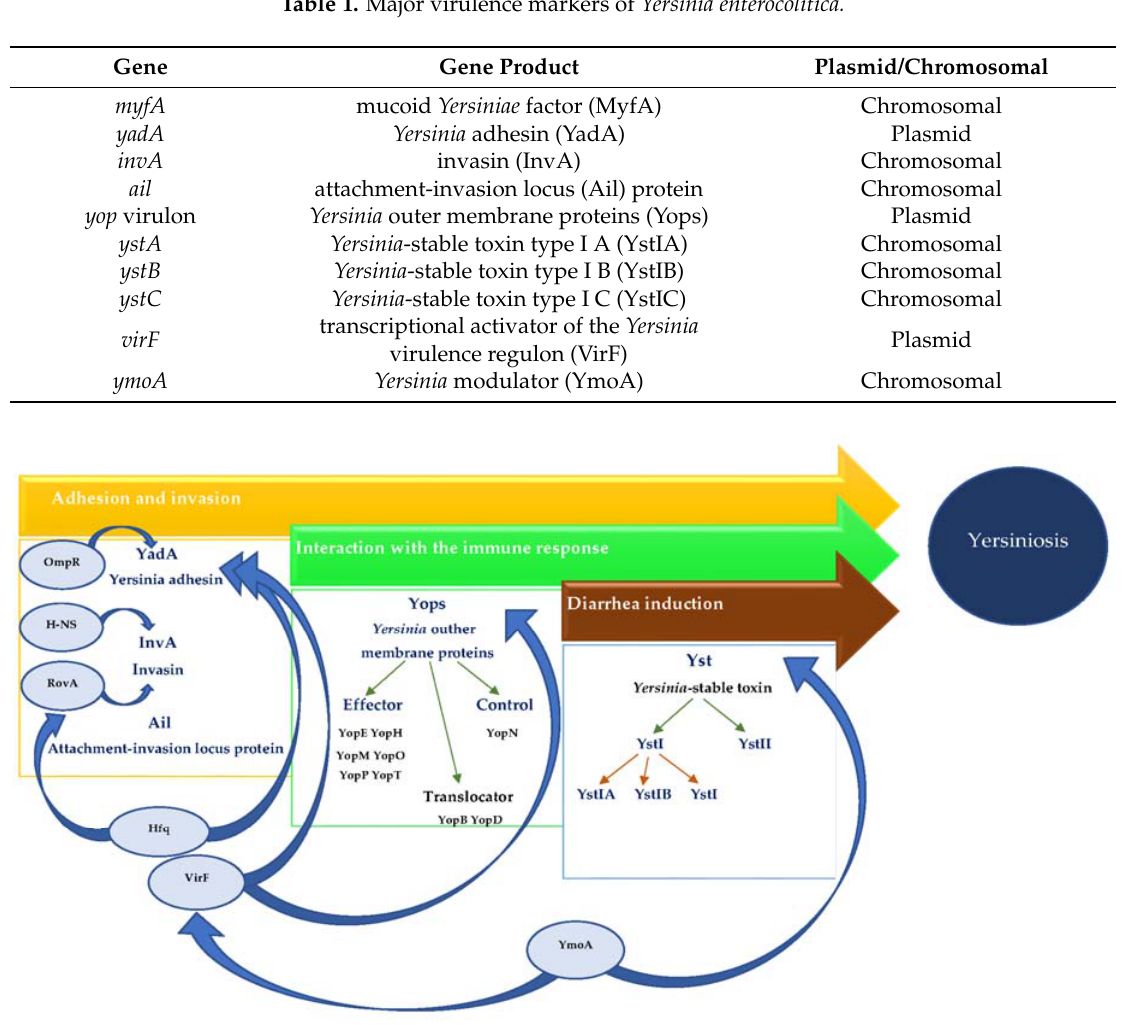
Table 1. Major virulence markers of Yersinia enterocolitica.